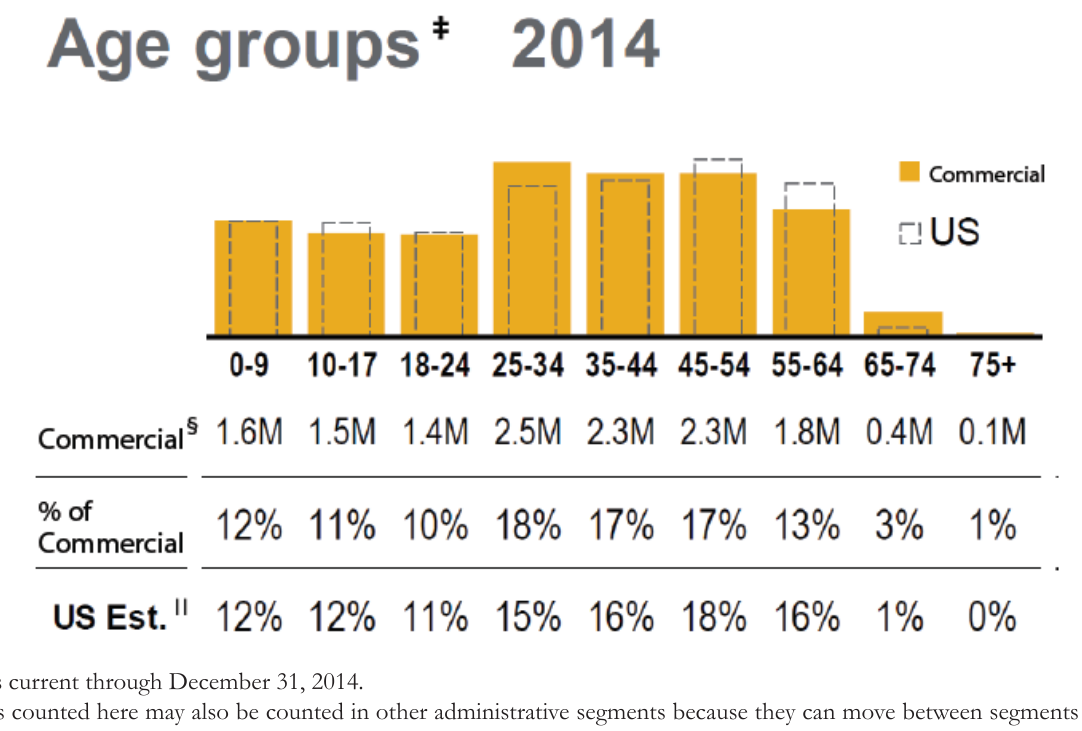
Figure 2. Age Distribution Comparison between Commercial and National Databases